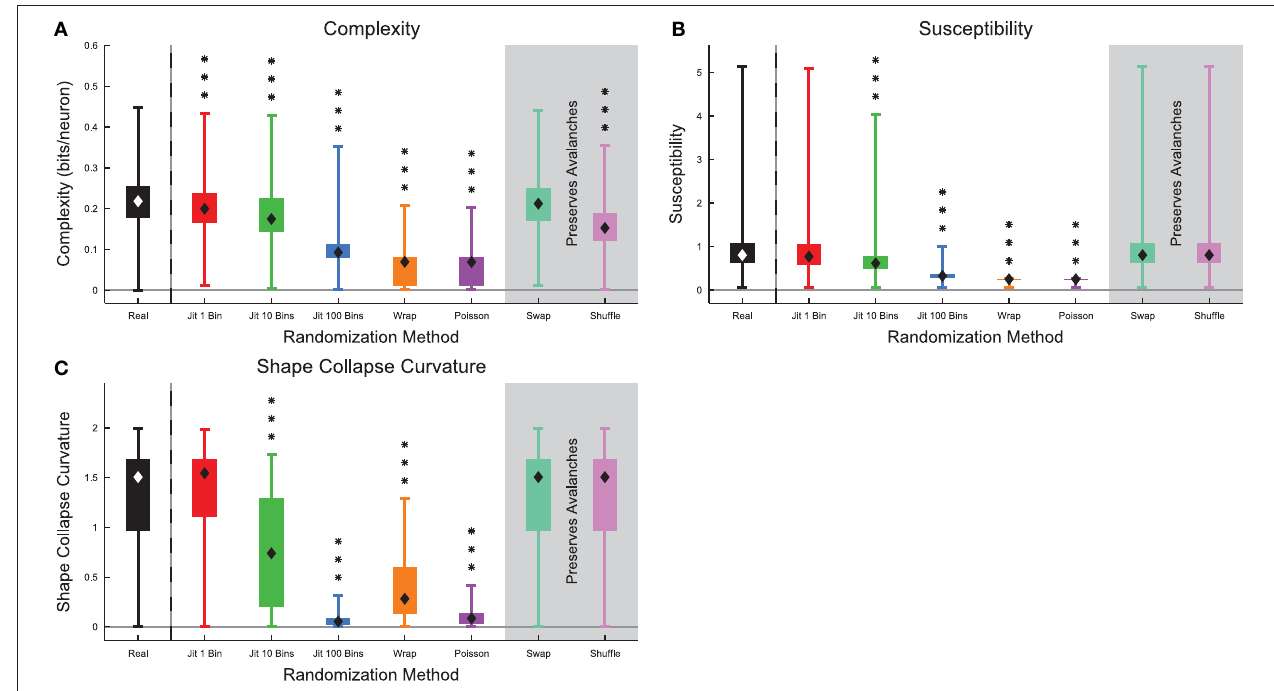
FIGURE 10 | Markers of criticality decreased under randomization in culture data. (A) Complexity decreased under randomization, with the exception of spike swapping (see Figure 12 ). (B) The susceptibility decreased under randomization. (C) Avalanche shape collapse curvature decreased under randomization, indicating that the shape collapses became flatter. Note that the susceptibility and shape collapse curvature were not expected to change under spike swapping or shuffling because those randomization methods preserved avalanche profiles. Box Plots: minimum value, 25th percentile, median, 75th percentile, maximum value. Rank Sum Test: ( p < 0.05) 1 star, ( p < 0.01) 2 stars, and ( p < 0.001) 3 stars. Multiple comparisons correction performed using false discovery rate control ( Benjamini and Hochberg, 1995; Benjamini and Yekutieli, 2001; Groppe et al.,